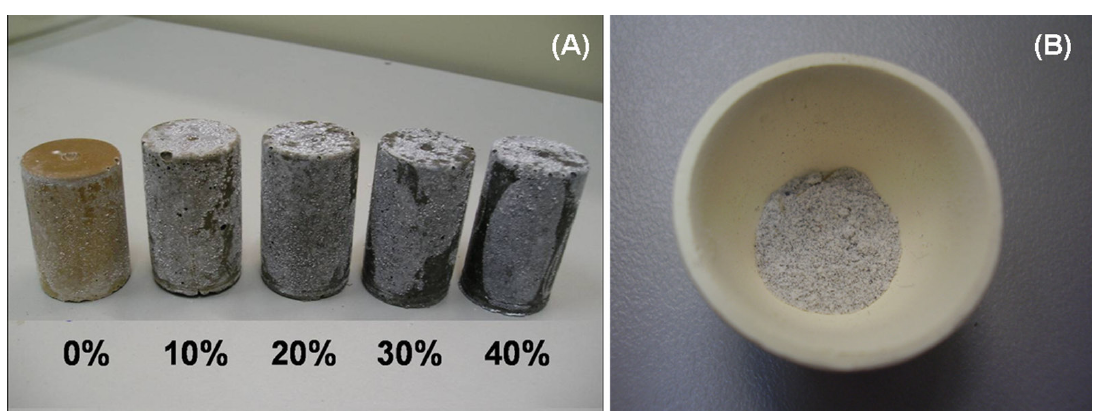
Table 4. Mass loss ( Δ M) and volume reduction ( Δ V) of the magnesium phosphate cement mortars containing grinding dust, subjected to accelerated aging for a period equivalent to one year. Waste Content Composition Mortars - 0.5 SiO 2 Mortars - 1.0 SiO 2